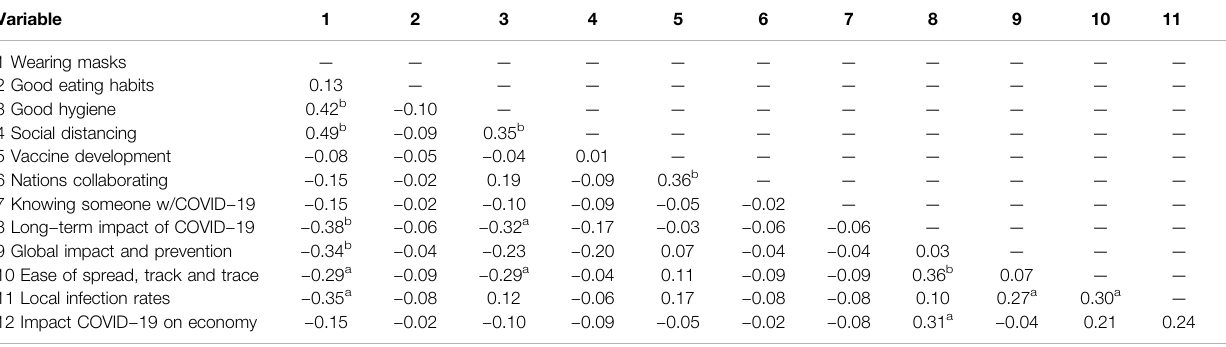
TABLE 5 | Combined RoK and Vietnam correlations on most useful information during COVID-19.